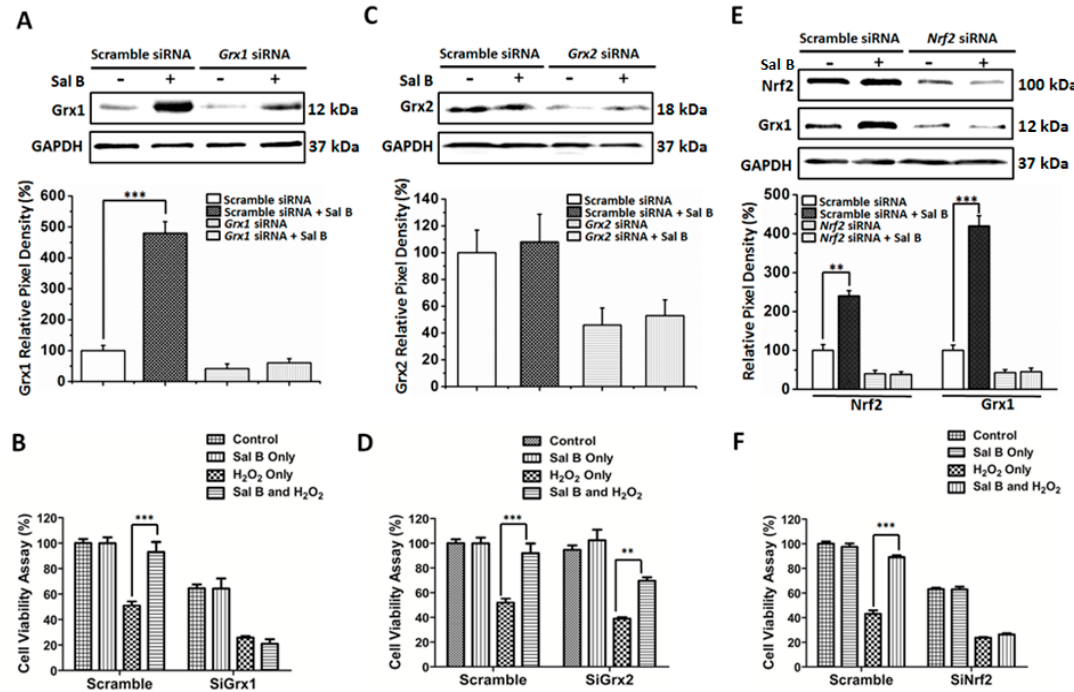
Figure 7. Grx1 and Nrf2 knockdown abolish the cytoprotective effects of Sal B. RPE cells were transfected with scramble or Grx1 siRNA and then incubated with or without 50 µ M Sal B for additional 24 h followed by H 2 O 2 treatment for 6 h. ( A ) Western blot analysis of Grx1 protein levels. Total protein of each sample was subjected to Western blot with Grx1 and GAPDH antibodies. Bottom panel: the relative pixel density of Grx1 over GAPDH. *** p < 0.001 compared with the scramble siRNA control group ( n = 3); ( B ) Grx1 knockdown abolished the cytoprotective effects of Sal B. Cell viability in each group was measured using a WST-8 assay. Values are the mean ± SEM of three experiments, n = 6; *** p < 0.001 compared with the H 2 O 2 -treated group; ( C ) Western blot analysis of Grx2 protein levels. RPE cells were transfected with scramble or Grx2 siRNA and then incubated with or without 50 µ M Sal B for additional 24 h followed by H 2 O 2 treatment for 6 h. Total protein of each sample was subjected to Western blot with Grx2 and GAPDH antibodies. Bottom panel: The relative pixel density of Grx2 over GAPDH. *** p < 0.001 compared with the scramble siRNA control group ( n = 3); ( D ) Grx2 knockdown did not change the cytoprotective effects of Sal B. Cell viability in each group was measured using a WST-8 assay. Values are the mean ± SEM of three experiments, n = 6; ** p < 0.01, *** p < 0.001 compared with H 2 O 2 -treated group; ( E ) Nrf2 gene silencing inhibited Sal B-mediated Grx1 induction. RPE cells were transfected with scramble or Nrf2 siRNA and then incubated with or without 50 µ M Sal B for additional 24 h followed by H 2 O 2 treatment for 6 h. Total protein of each sample was subjected to western blot with Nrf2, Grx1, and GAPDH antibodies. Bottom panel: the relative pixel density of Nrf2 and Grx1 over GAPDH. ** p < 0.01, *** p < 0.001 compared with the scramble siRNA control group ( n = 3); and ( F ) Nrf2 siRNA abolished the cytoprotective effects of Sal B. Cell viability in each group was measured using a WST-8 assay. Values are the mean ± SEM of three experiments ( n = 6), *** p < 0.001 compared with H 2 O 2 -treated group.